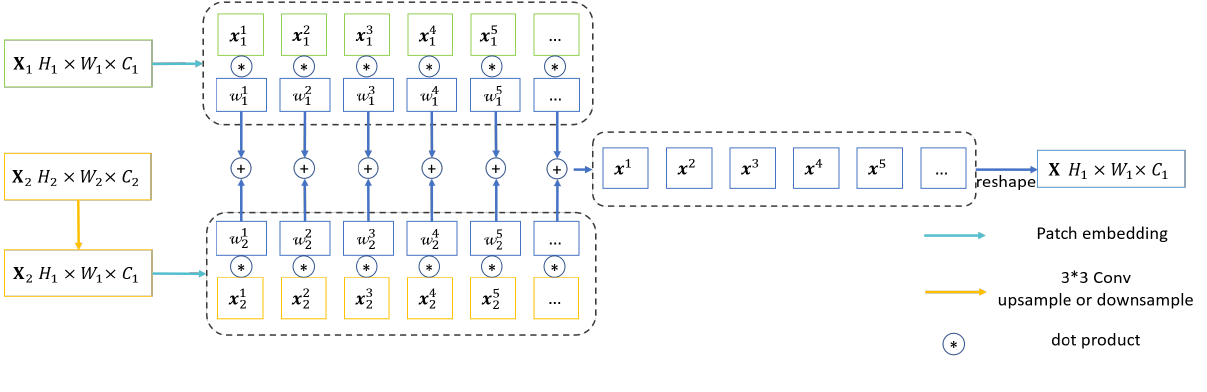
Figure 6. The feature fusion